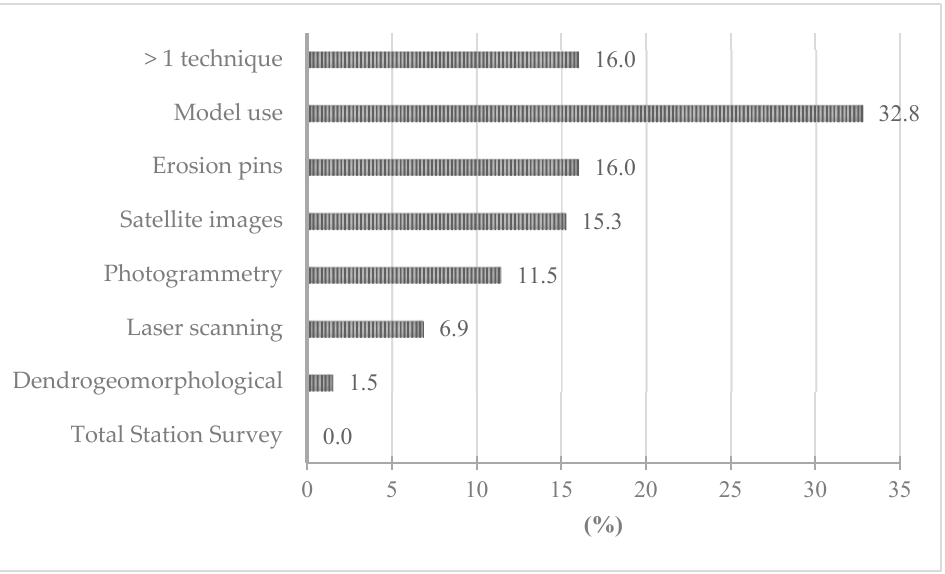
Figure 4. Distribution of investigation techniques used to quantify margin erosion in the literature.